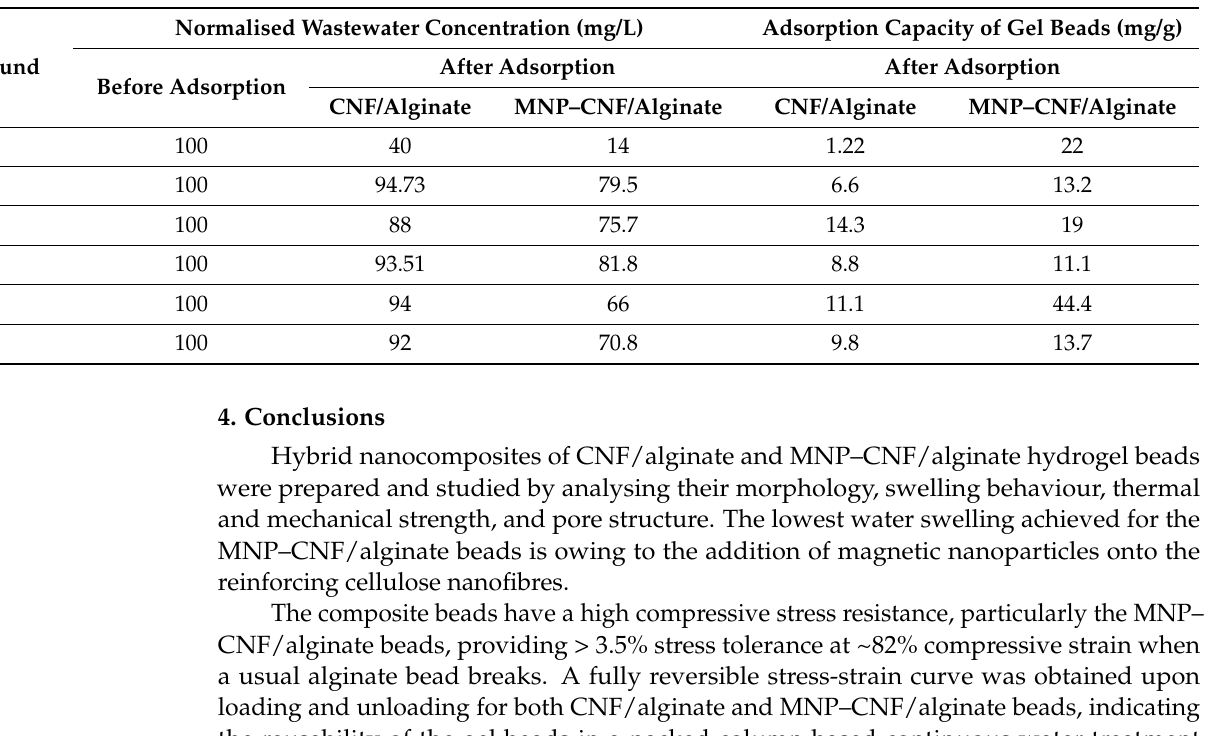
Table 3. Pollutant concentration in wastewater before and after the adsorption by gel